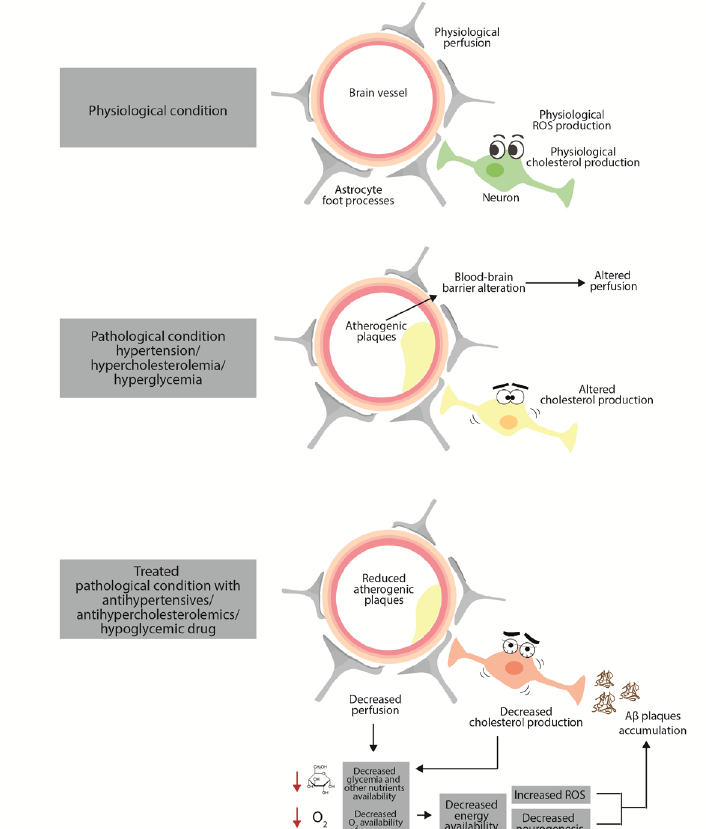
Figure 3. Mechanisms potentially involved in drug-related alteration of neuronal function in the central nervous system. Antihypertensives in combination with reduced glucose availability and antihypercholesterolemic drugs can compromise metabolism and key cellular functions, thereby compromising neuronal survival. →: implication; →: